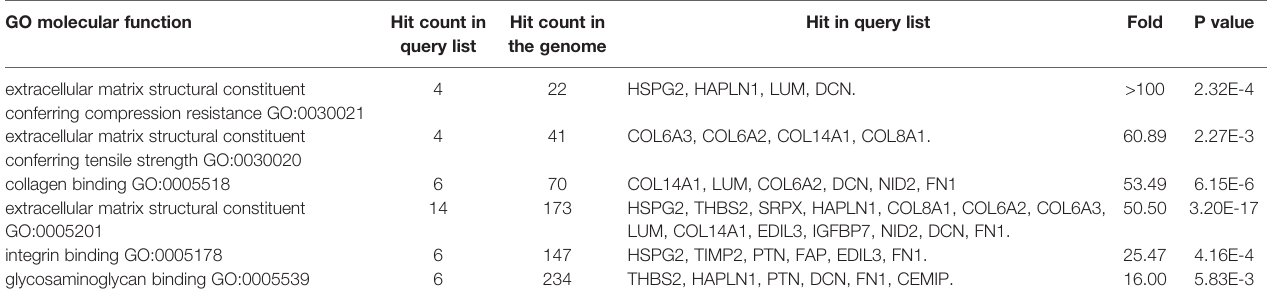
TABLE 7 | Most enriched GO terms: Molecular function, classed by fold increase. GO molecular function Hit count in